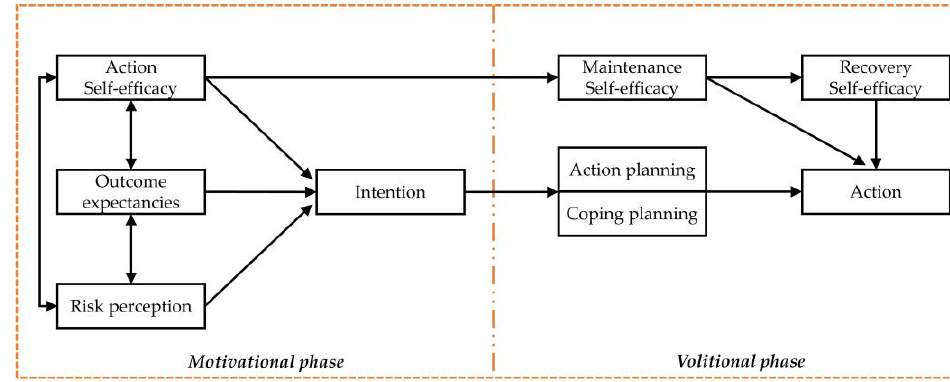
Figure 2. The health action process approach theory. [28].